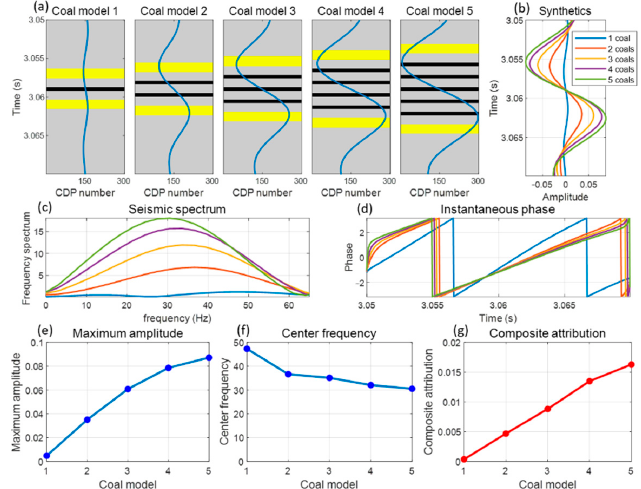
Figure 7. Model of thin coal seams coupled with sandstone and its synthetics and attributes: ( a ) coal model, ( b ) synthetic, ( c ) seismic frequency spectrum, ( d ) instantaneous phase, ( e ) maximum ampli- tude, ( f ) centre frequency, and ( g ) composite attribute.